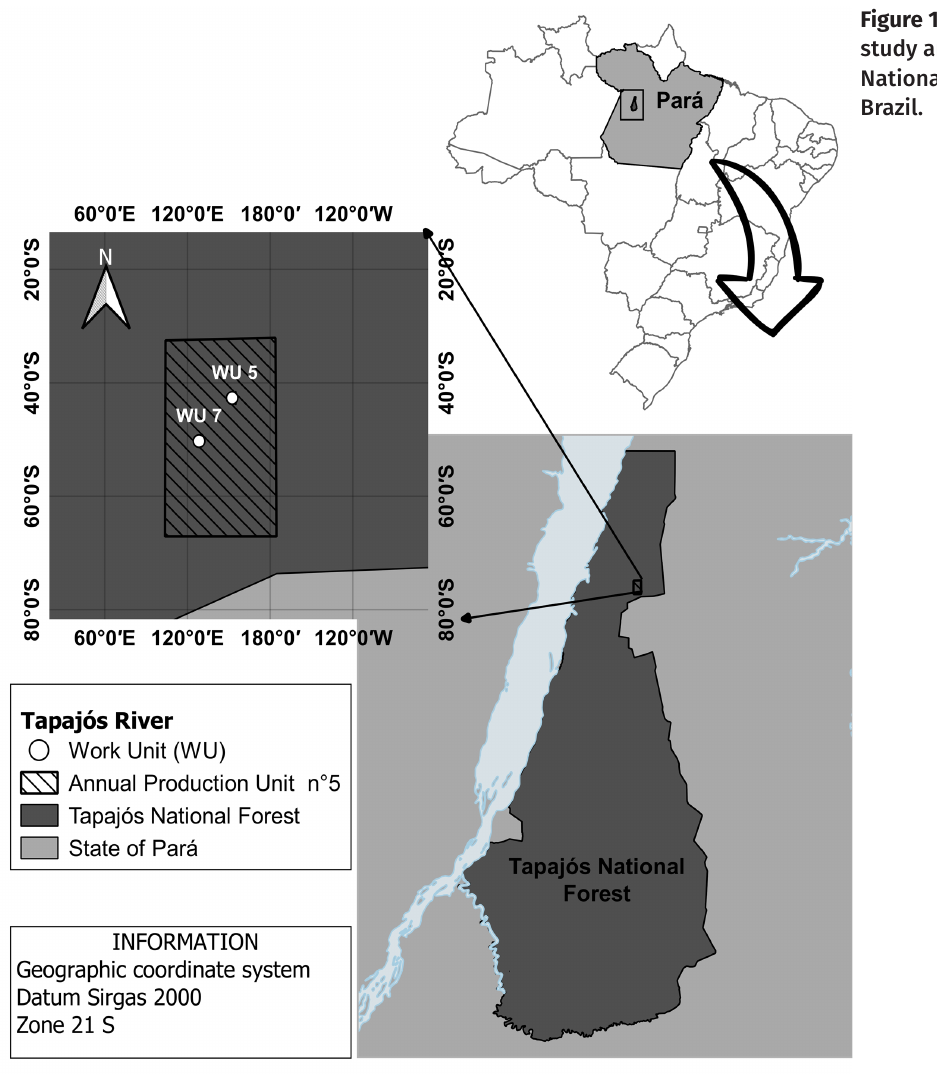
Figure 1. Location of